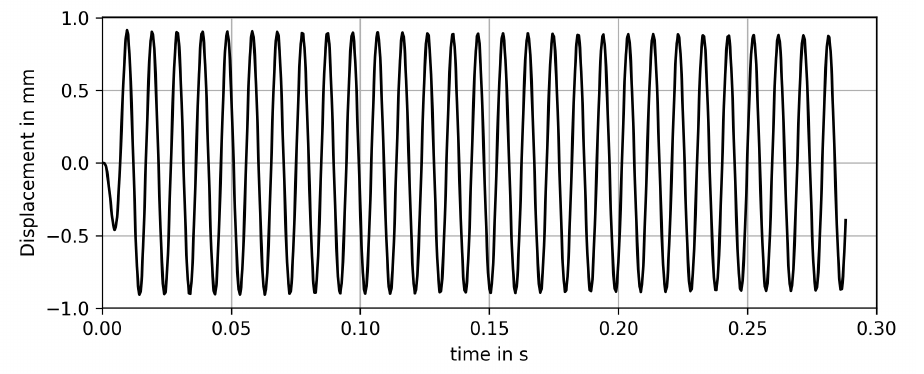
Figure 11. Structural response at frequency f exc =